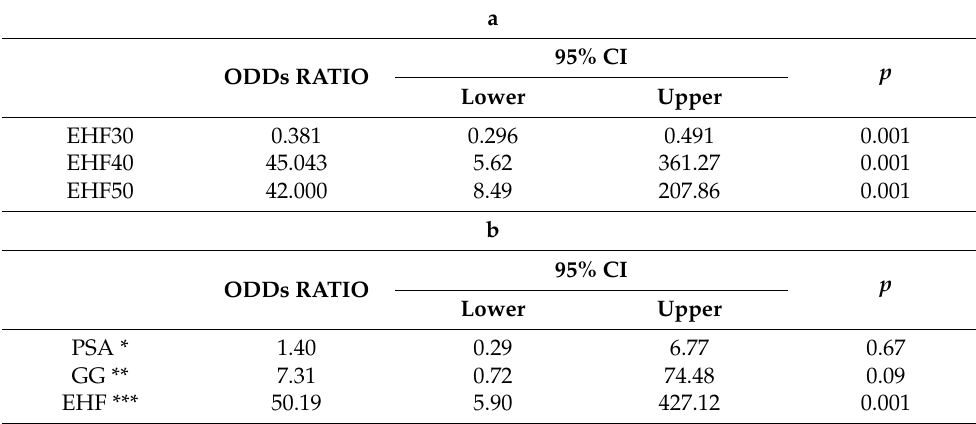
Table 1. SPA, Gleason group, EHF expression, and the risk of prostate metastasis formation. a ODDs